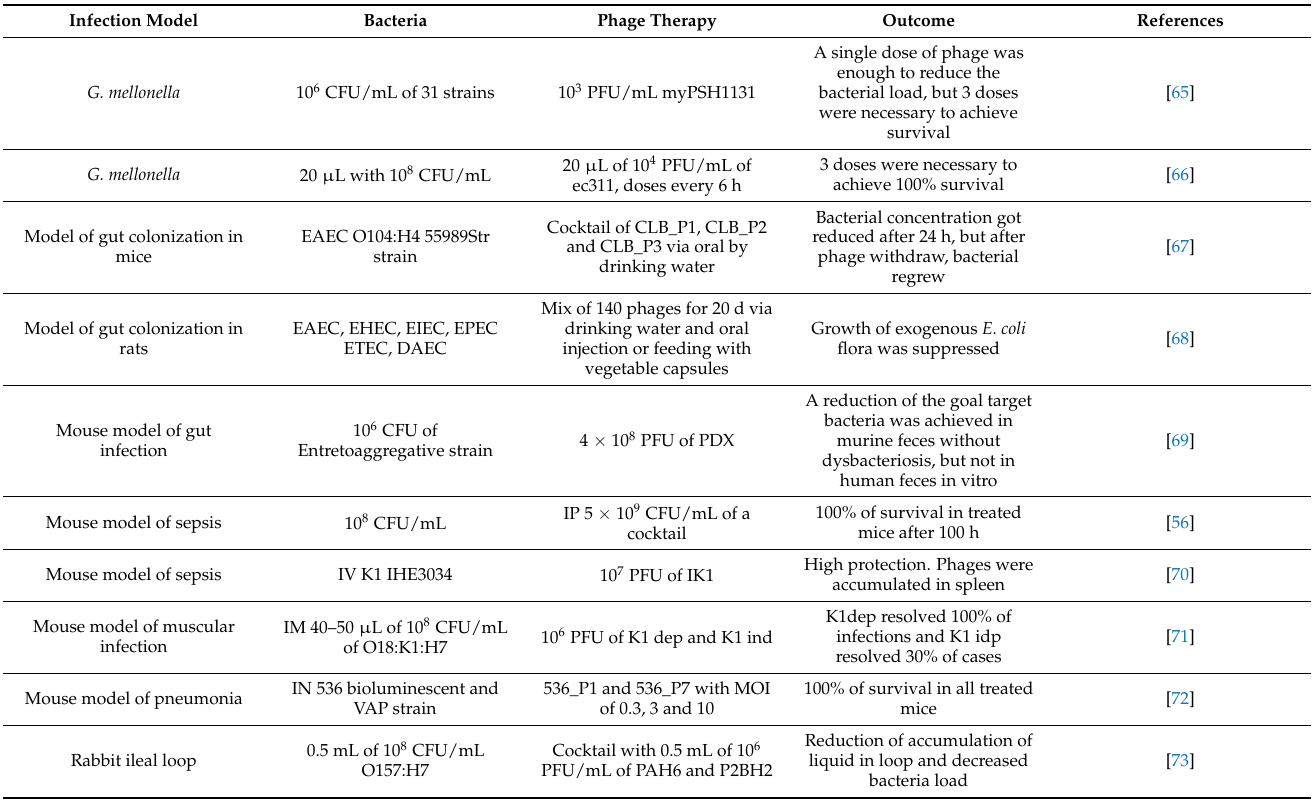
Table 3. Summary of in vivo studies using phage therapy against E. coli from 2010 to